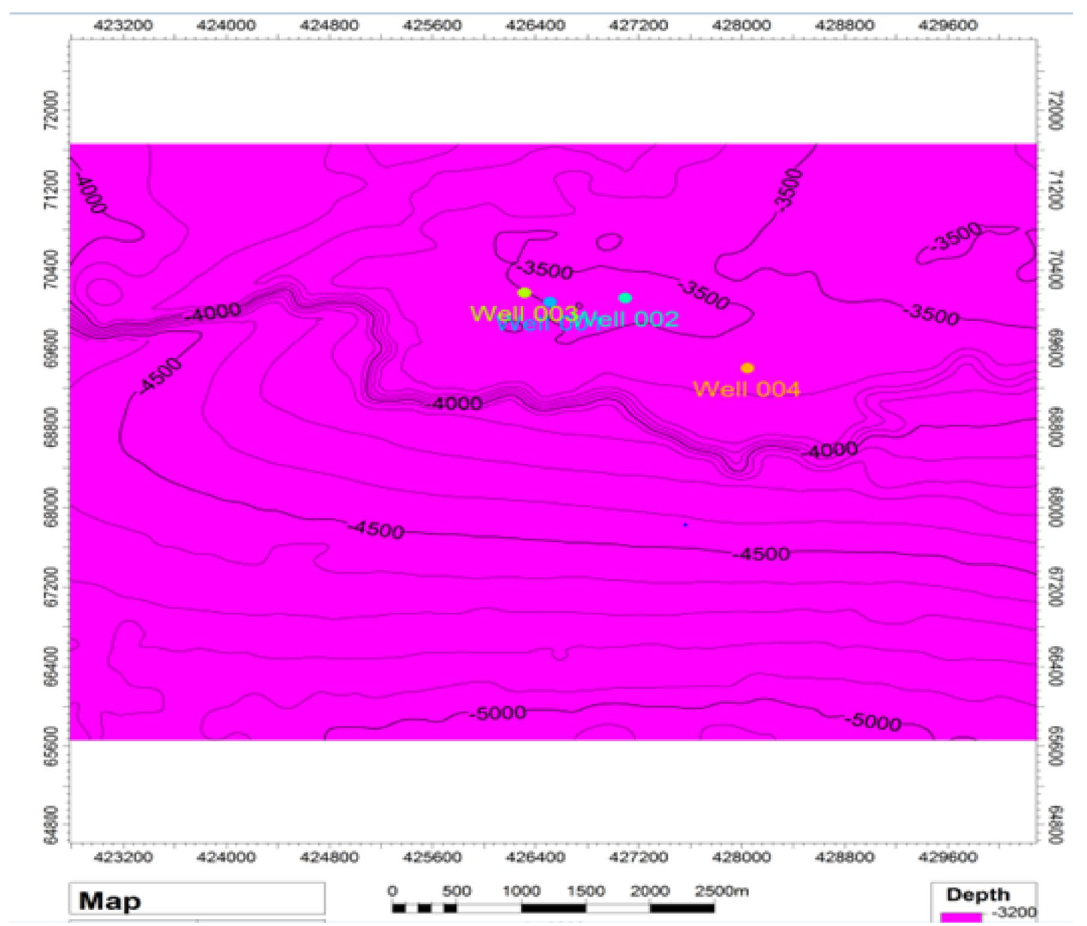
Fig. 10 Depth map. This figure shows the generated isopach map, indicating the position of the well location of the study